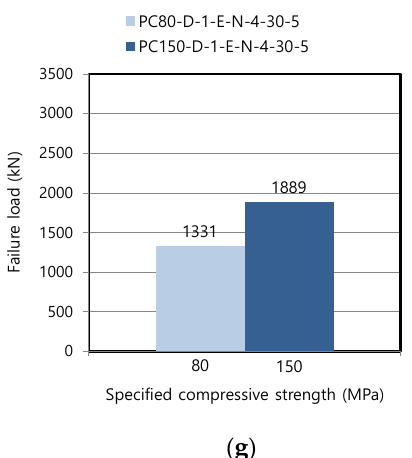
Figure 6. Failure loads in dry joint for each variable: ( a ) number of shear keys; ( b ) lateral compressive stress; ( c ) shear key height; ( d ) filler type; ( e ) compressive strength (Case 1); ( f ) compressive strength (Case 2); and ( g ) compressive strength (Case 3).